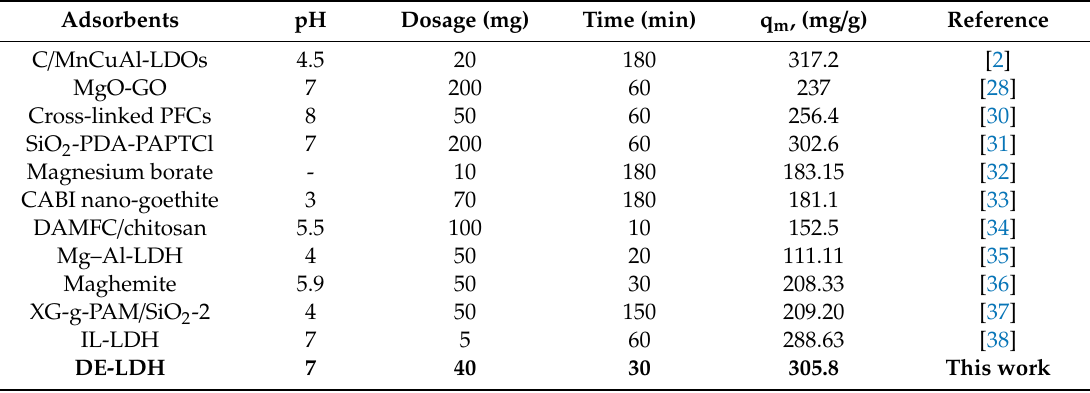
Table 4. Comparison of DE-LDH with reported di ff erent adsorbent in the adsorption of CR.